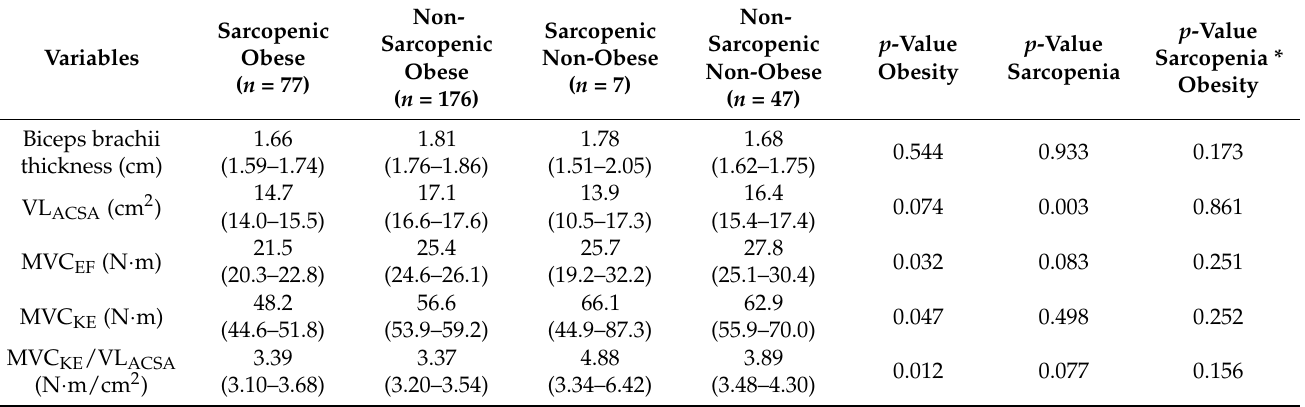
Table 2. Muscle size, strength, and quality among groups (phenotype data are presented as means (95% confidence intervals).